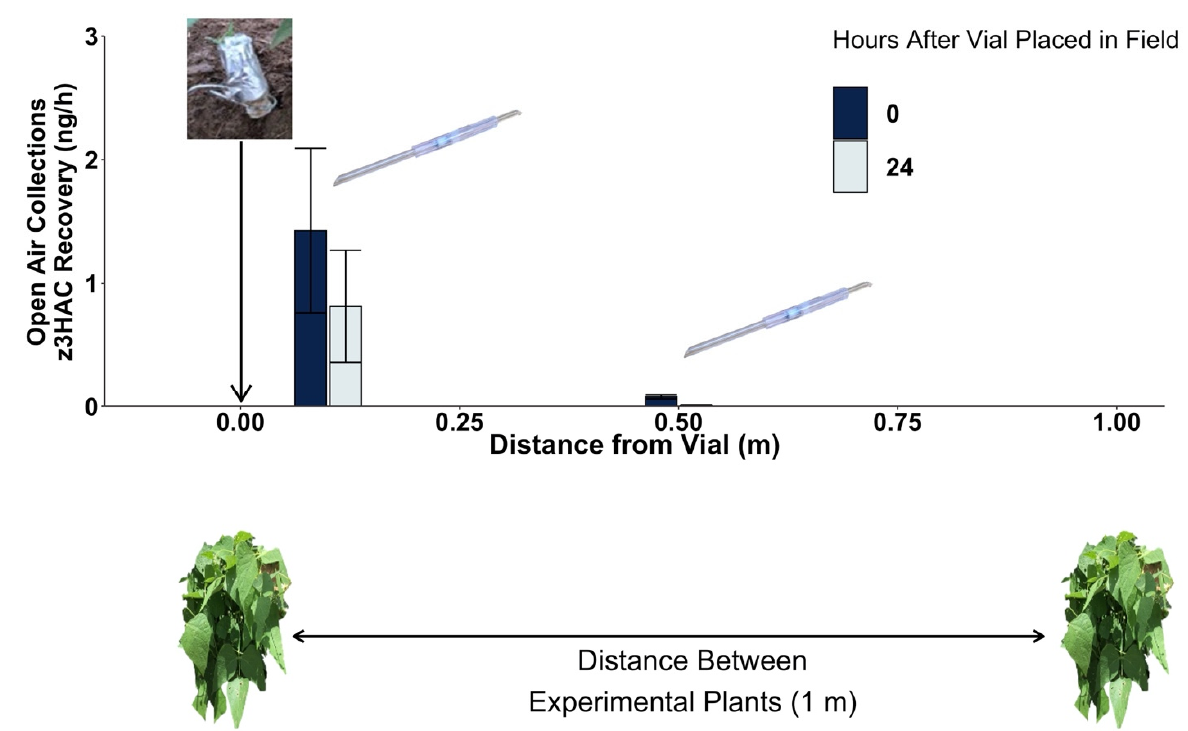
Figure 1. Recovery of cis -3-hexenyl acetate ( z 3HAC) in open-air collections. Volatile collection filters were placed 0.1 m and 0.5 m from experimental z 3HAC vials (n = 4). Open-air collections were made immediately (0 h) and 24 h after the vials were placed in the field. z 3HAC was recovered at the close sampling range of 10 cm even after 24 h of the vial but only minimally detected 0.5 m from the vial. For comparison, experimental plants were spaced 1 m apart.